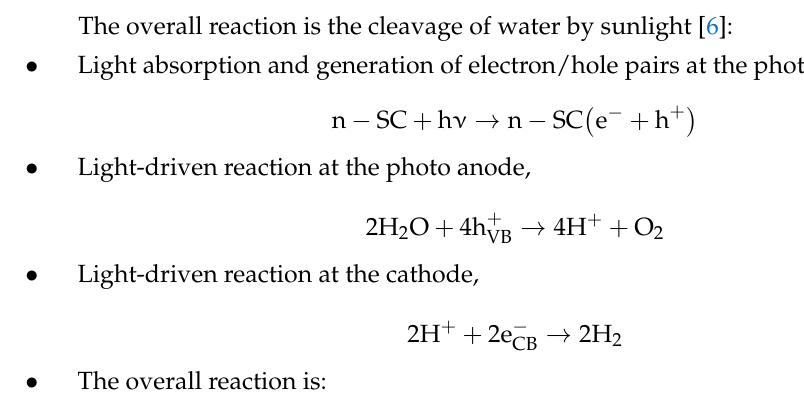
Figure 2. Photolysis of water by using an n-type semiconductor electrode.